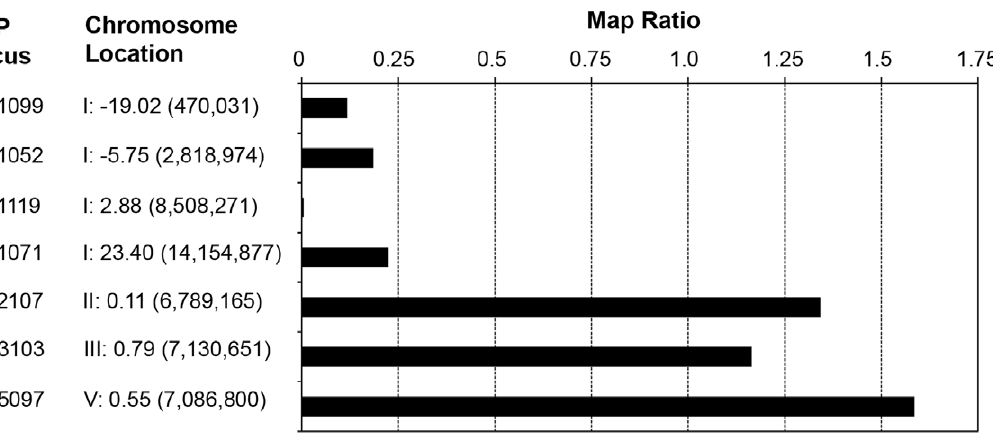
Figure 1. SNP mapping data for hc197 on Chromosome I. Map ratios near zero indicate linkage, while ratios near 1 indicate independent segregation. The SNP loci and chromosome locations (chromosome number, genetic map position, physical map location) are indicated.